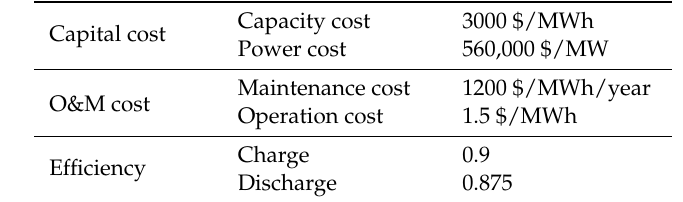
Table 3. Parameters of energy storage system.